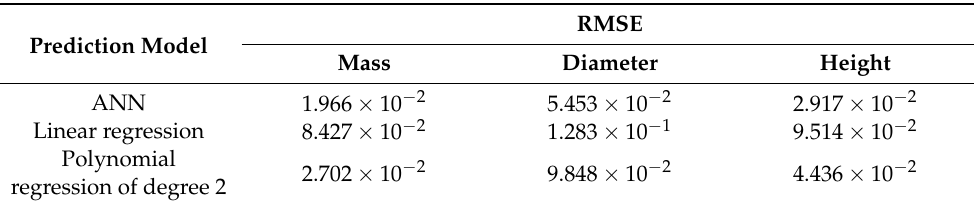
Table 12. Root mean square errors (RMSEs) of normalized test data for prediction models learned by the nonlinear relation group (packing time was 3.0–39.0